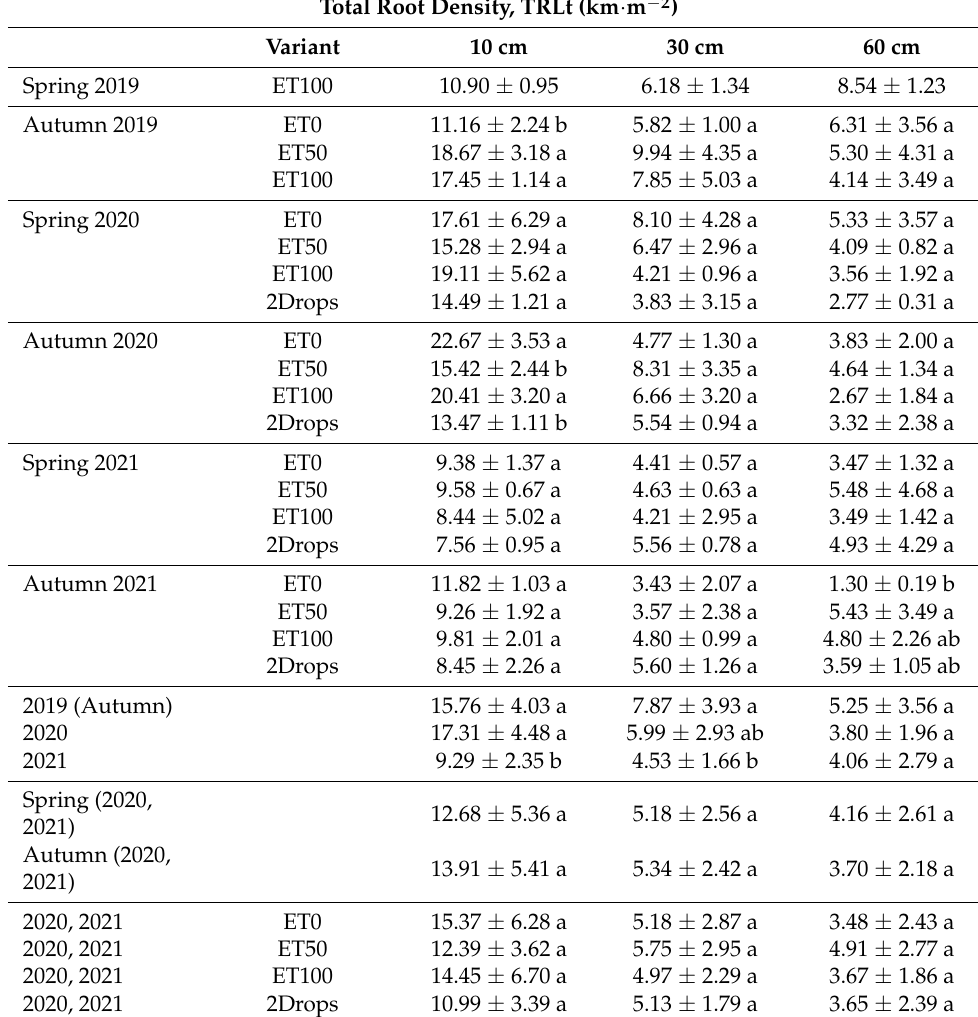
Table 3. Total root length of all roots to a depth of 80 cm (TRLt) at distances of 10 cm, 30 cm, and 60 cm from the tree trunk, in experimental years and variants. ET0, ET50, ET100, and 2Drops refer to irrigation water rate variants (see Figure